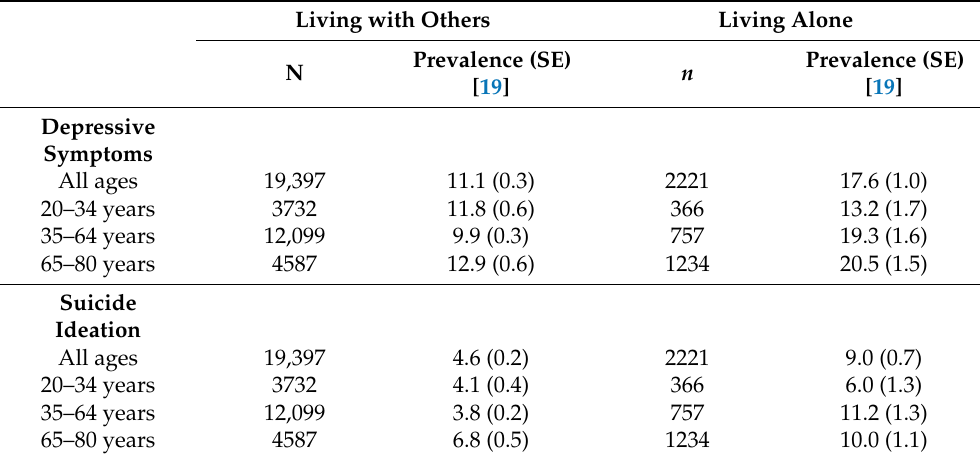
Table 3. Prevalence of depressive symptoms and suicidal ideation among those living alone and those living with others. Living with Others Living Alone Prevalence Prevalence (SE) n N